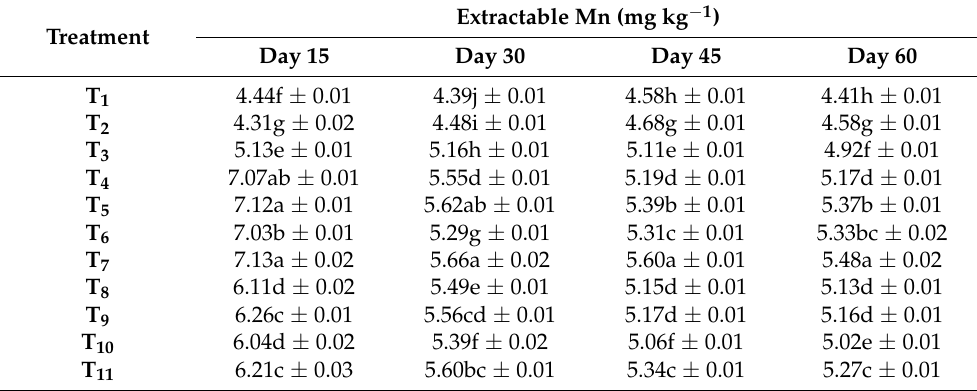
Table 13. Effect of RHB, EFBB, and dolomitic limestone treatments on soil extractable Mn.